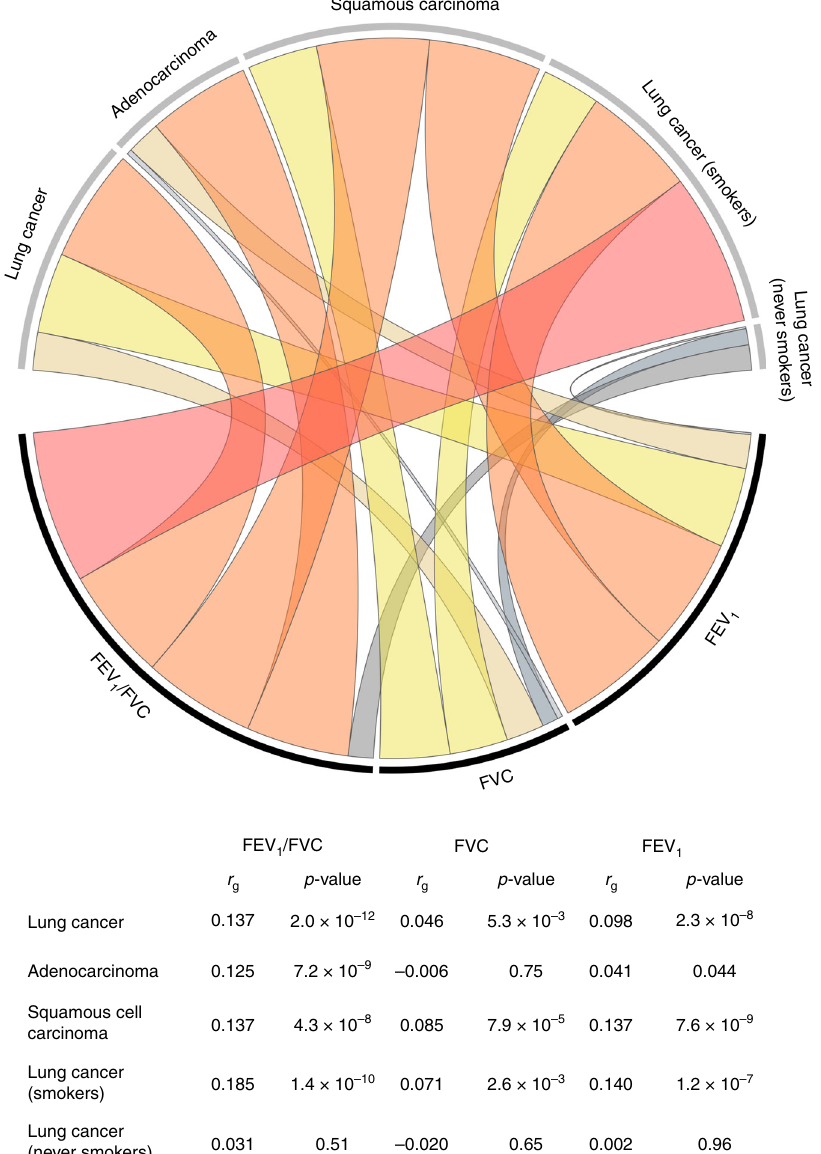
Fig. 3 Genetic correlation ( r g ) between pulmonary function phenotypes and lung cancer subtypes. Estimates of r g are based on genome-wide summary statistics from the UK Biobank cohort for pulmonary traits, and the International Lung Cancer Consortium OncoArray study for lung cancer. Genetic correlations have been rescaled to depict associations between impaired (reduced) pulmonary function and lung cancer risk. The colors in the Circos plot correspond to the direction of genetic correlation, with warm shades depicting positive correlations between impaired pulmonary function and lung cancer risk, and gray tones corresponding to inverse and null correlations. The width of each band in the Circos plot is proportional to the magnitude of the absolute value of the r g